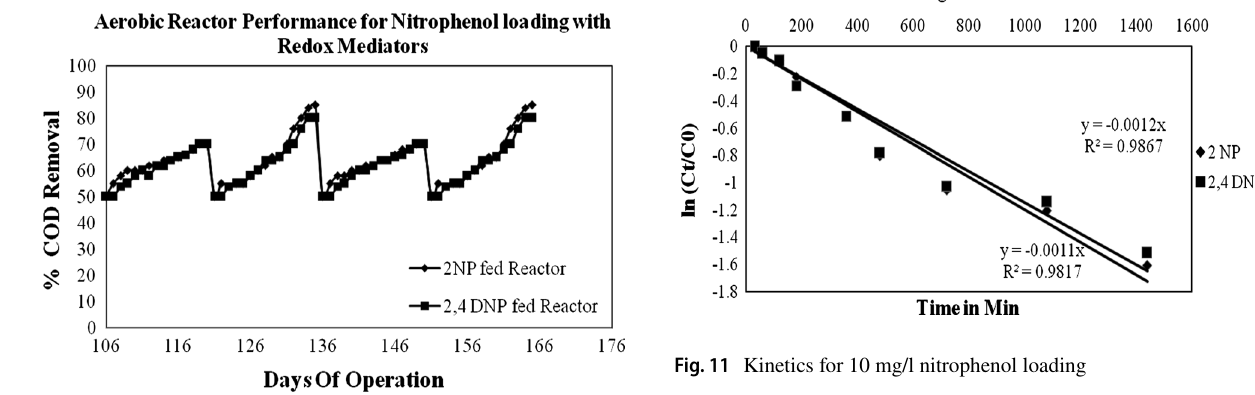
Fig. 11 Kinetics for 10 mg/l nitrophenol